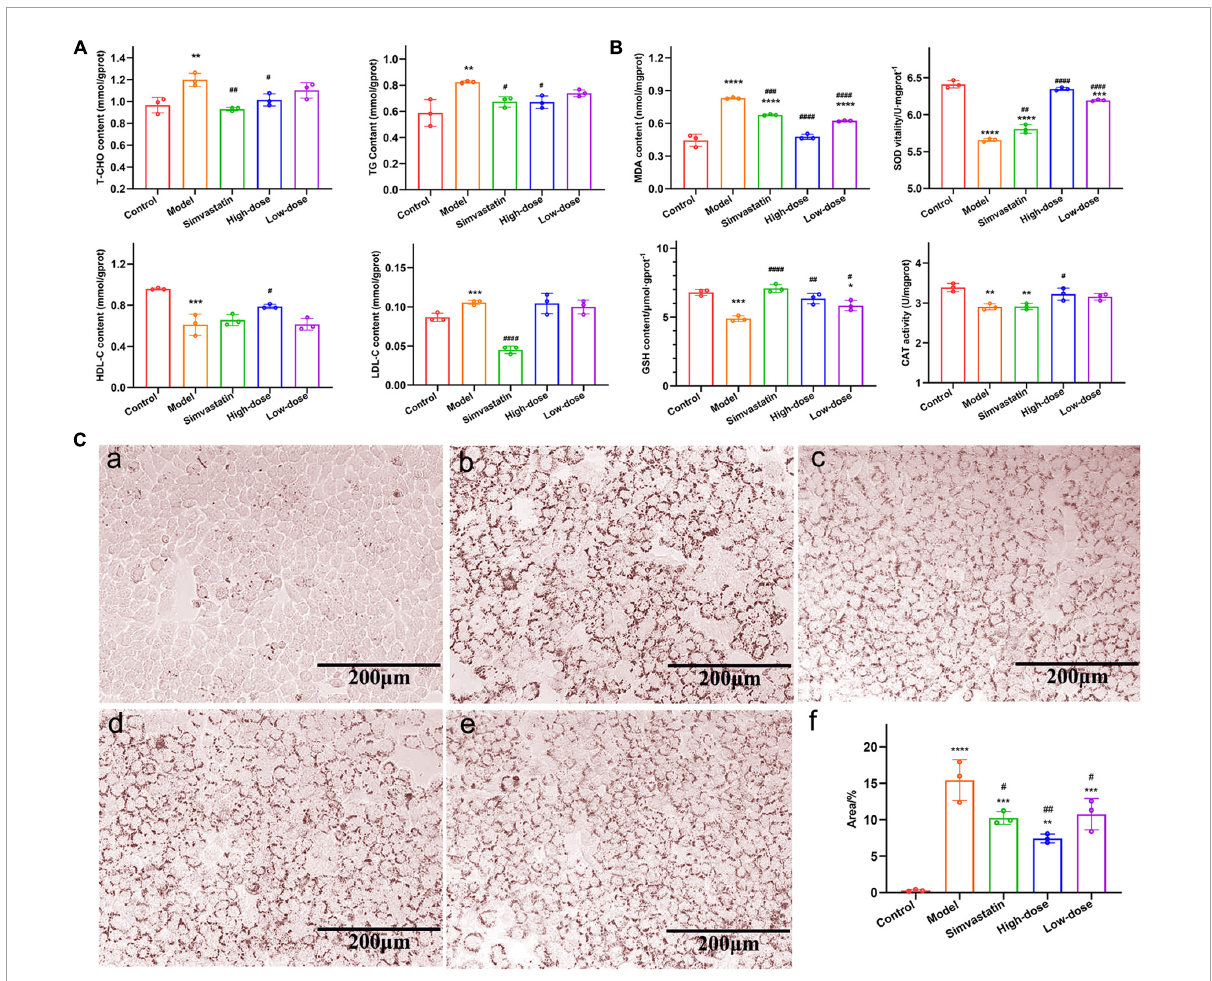
FIGURE2 Effect of hawthorn fruit acid (HFA) on lipid accumulation and oxidative stress in HepG2 cells. (A) T-CHO, TG, HDL-C, and LDL-C in HepG2 cells treated with HFA and 0.1 mM OA; (B) MDA, GSH, SOD, and CAT levels in HepG2 cells treated with HFA and 0.1 mM OA; (C) Oil-red O staining (20 × ) of HepG2 cells treated with HFA and 0.1 mM OA: (a–e) for control, model, simvastatin, high-dose and low-dose groups, respectively; (f) Statistical results of oil-red O stained areas. Data represent mean ± SD ( n = 3). Statistically significant results were indicated as * p < 0.05, ** p < 0.01, *** p < 0.001, and **** p < 0.0001 vs. control group; # p < 0.05, ## p < 0.01, ### p < 0.001, and #### p < 0.0001 vs. model